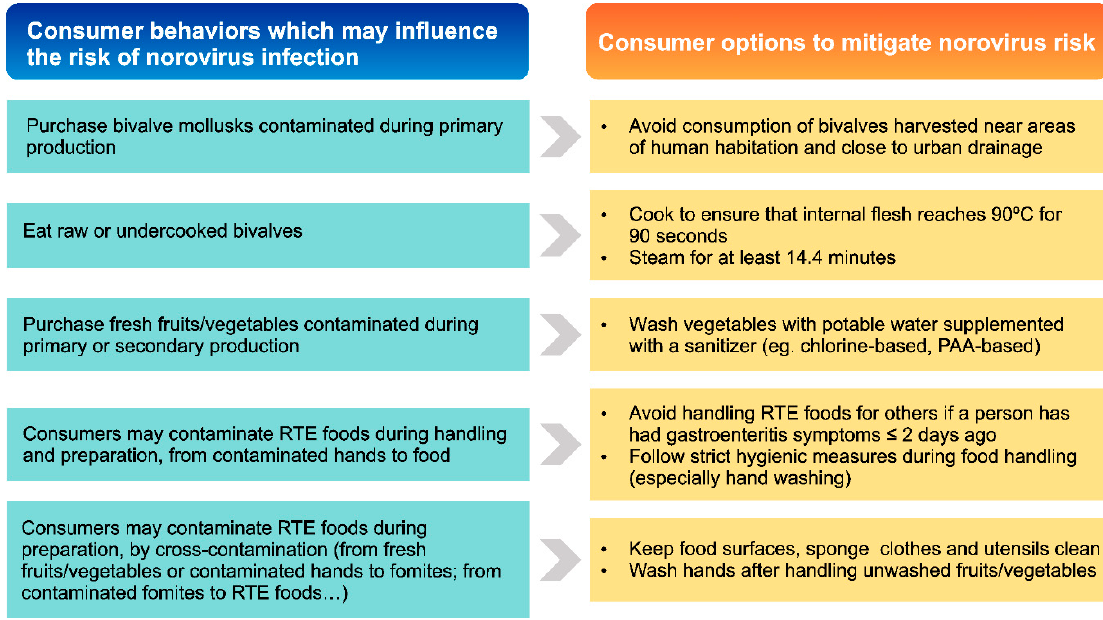
Figure 1. Major consumer habits and behaviors which may increase norovirus risk of infection, and options available for consumers to mitigate the risk.